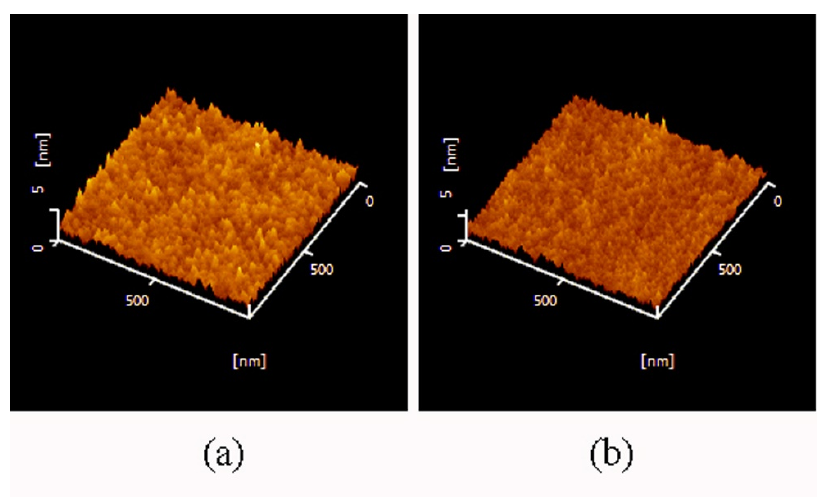
Figure 5. Surface analysis results for the ( a ) as-deposited and ( b ) HT923 ITO50:Al 2 O 3 (PHS) thin films. Table 2. Arithmetical mean height ( S a ) and root mean square height ( S q ) of depo. and